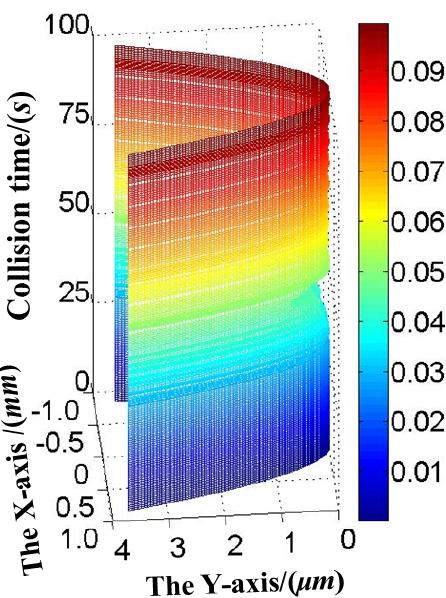
Figure 10. Strain diagram at the single collision point.